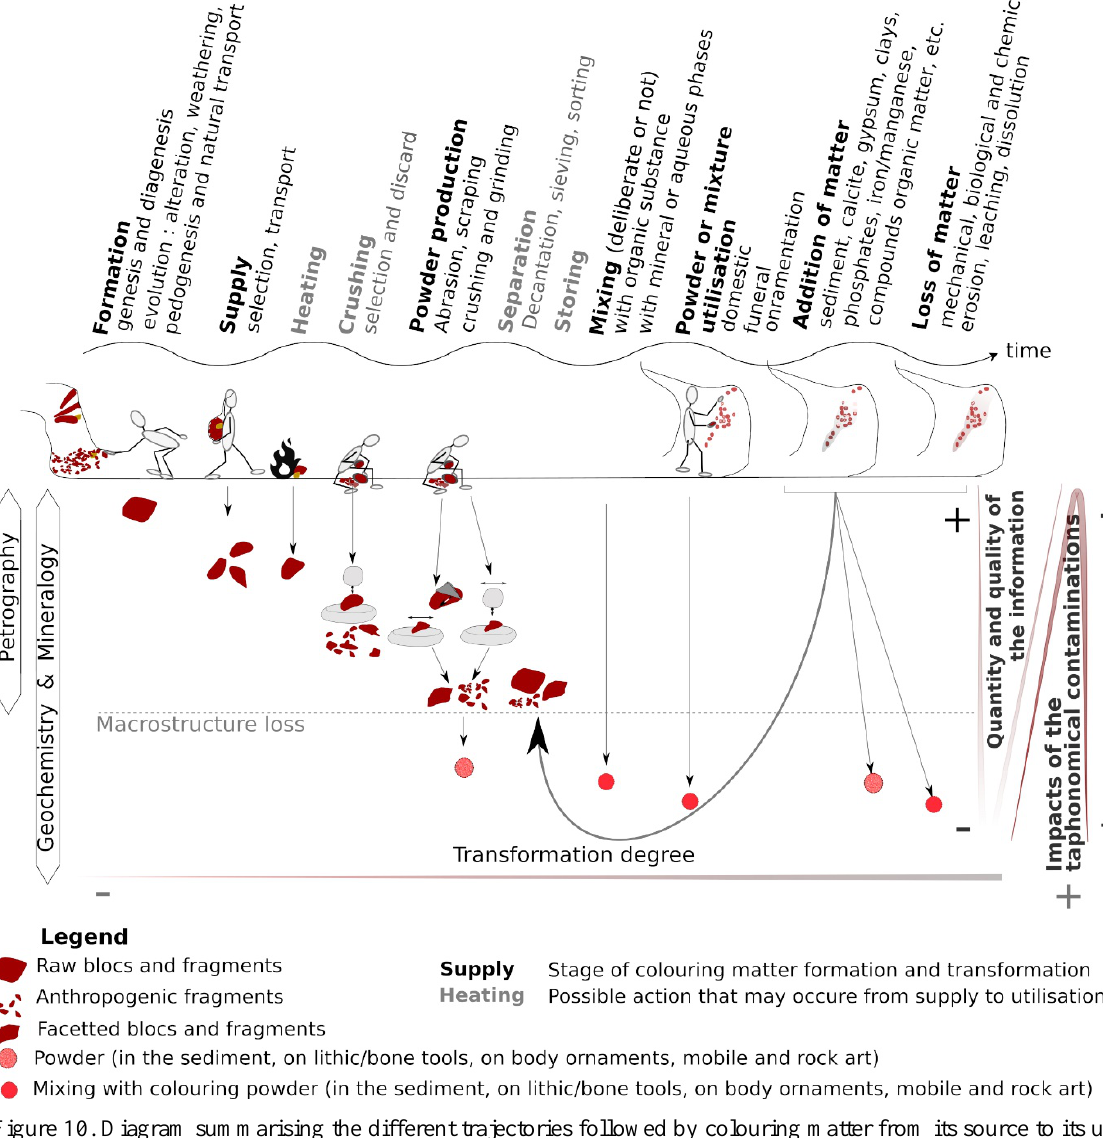
Figure 10. Diagram summarising the different trajectories followed by colouring matter from its source to its use and conservation, and involving different degrees of transformation. The amount of information about the material that is lost correlates with the degree of transformation. Diagram: H.